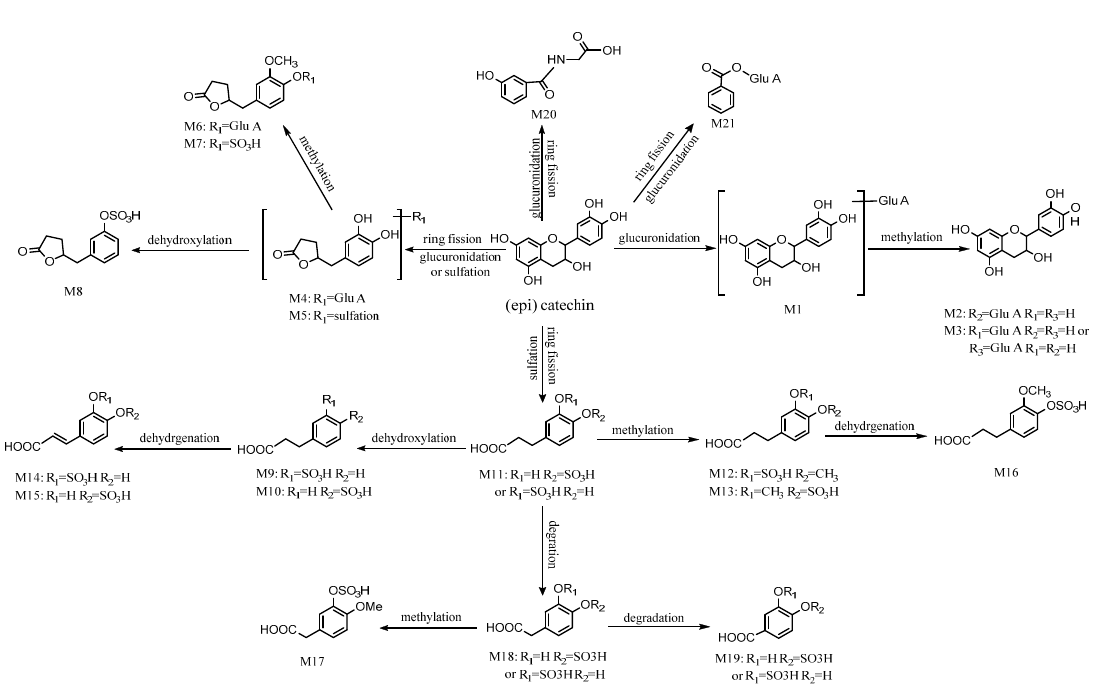
Figure 4. The potential metabolic profile of (epi) catechin-related metabolites.